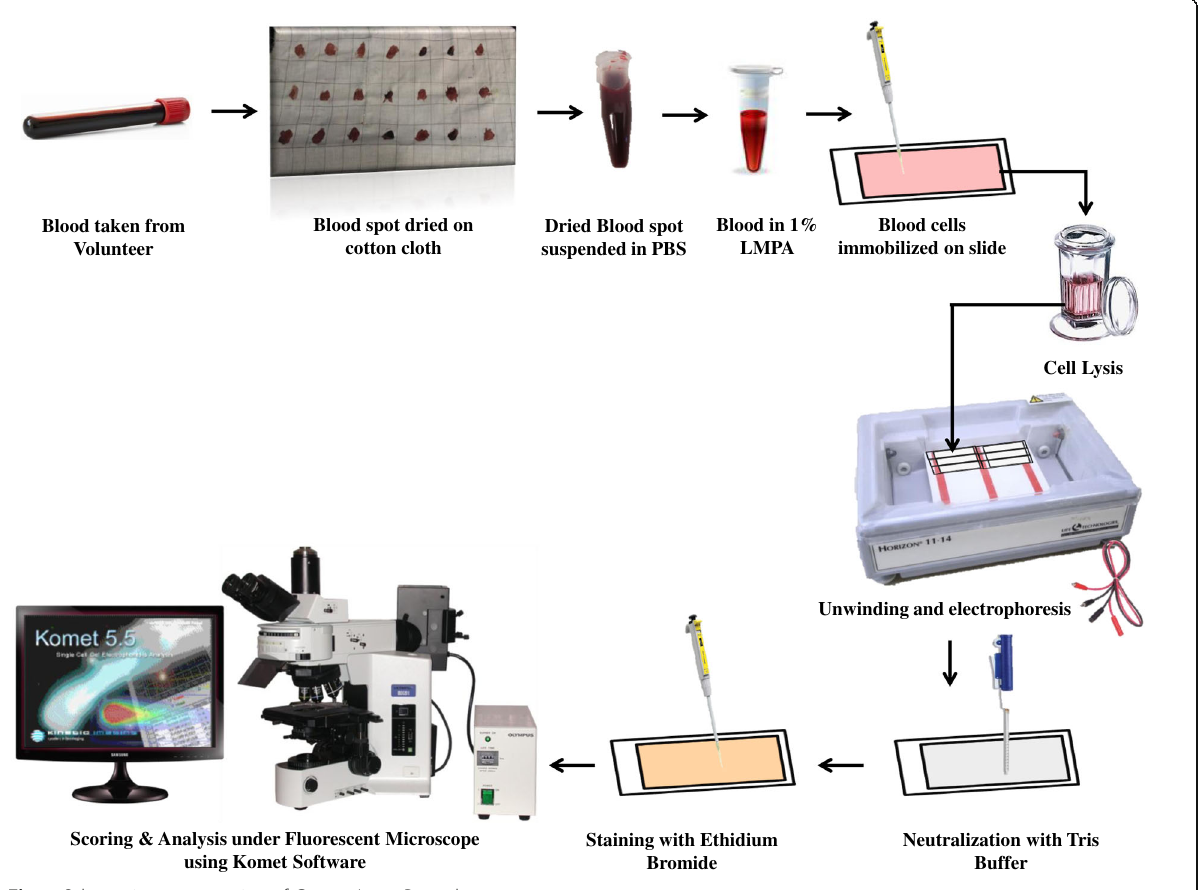
Fig. 1 Schematic representation of Comet Assay